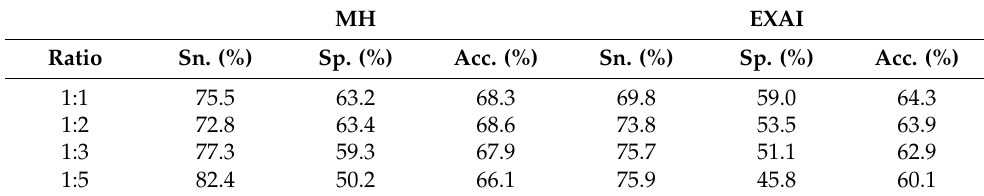
Table 5. Results for tested loss function ratios.